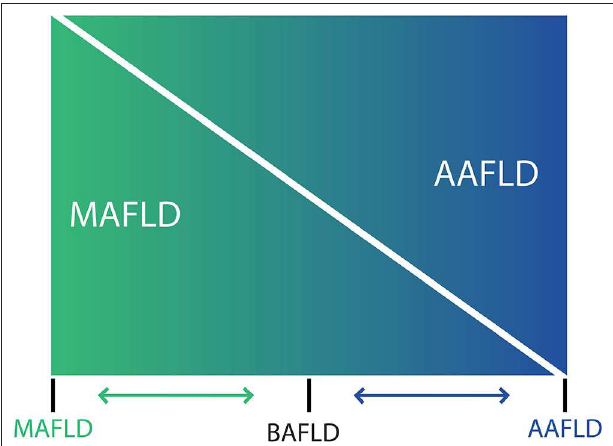
FIGURE 1 | Spectrum of fatty liver diseases. In non-alcoholic fatty liver disease (NAFLD) and alcohol-related liver disease have been generally conceived as different entities, and despite that both conditions share an overlapping pathophysiology and frequently coexist in clinical practice, thresholds to diagnose NAFLD makes difficult to account for a dual etiology in a given patient. For that reason, a nomenclature change has been proposed [see ( 71) in the main text] considering that at the ends of the spectrum of fatty liver disease, there are patients with true ALD (now named alcohol-associated fatty liver disease, AAFLD) and some with true NAFLD with alcohol consumption near-zero (now named metabolic associated fatty liver disease, MAFLD) but that the vast majority of patients are between these two extremes. Thus, in clinical practice there will be patients with ALD that have metabolic cofactors (AAFLD with MetS) and patients with NAFLD that consume alcohol, which contributes to the disease process (MAFLD with alcohol component). In the middle, a large group of patients have both conditions (NAFLD and ALD) with some showing an equal contribution of alcohol and metabolic factors (proposedly named as both alcohol and metabolic associated fatty liver disease,